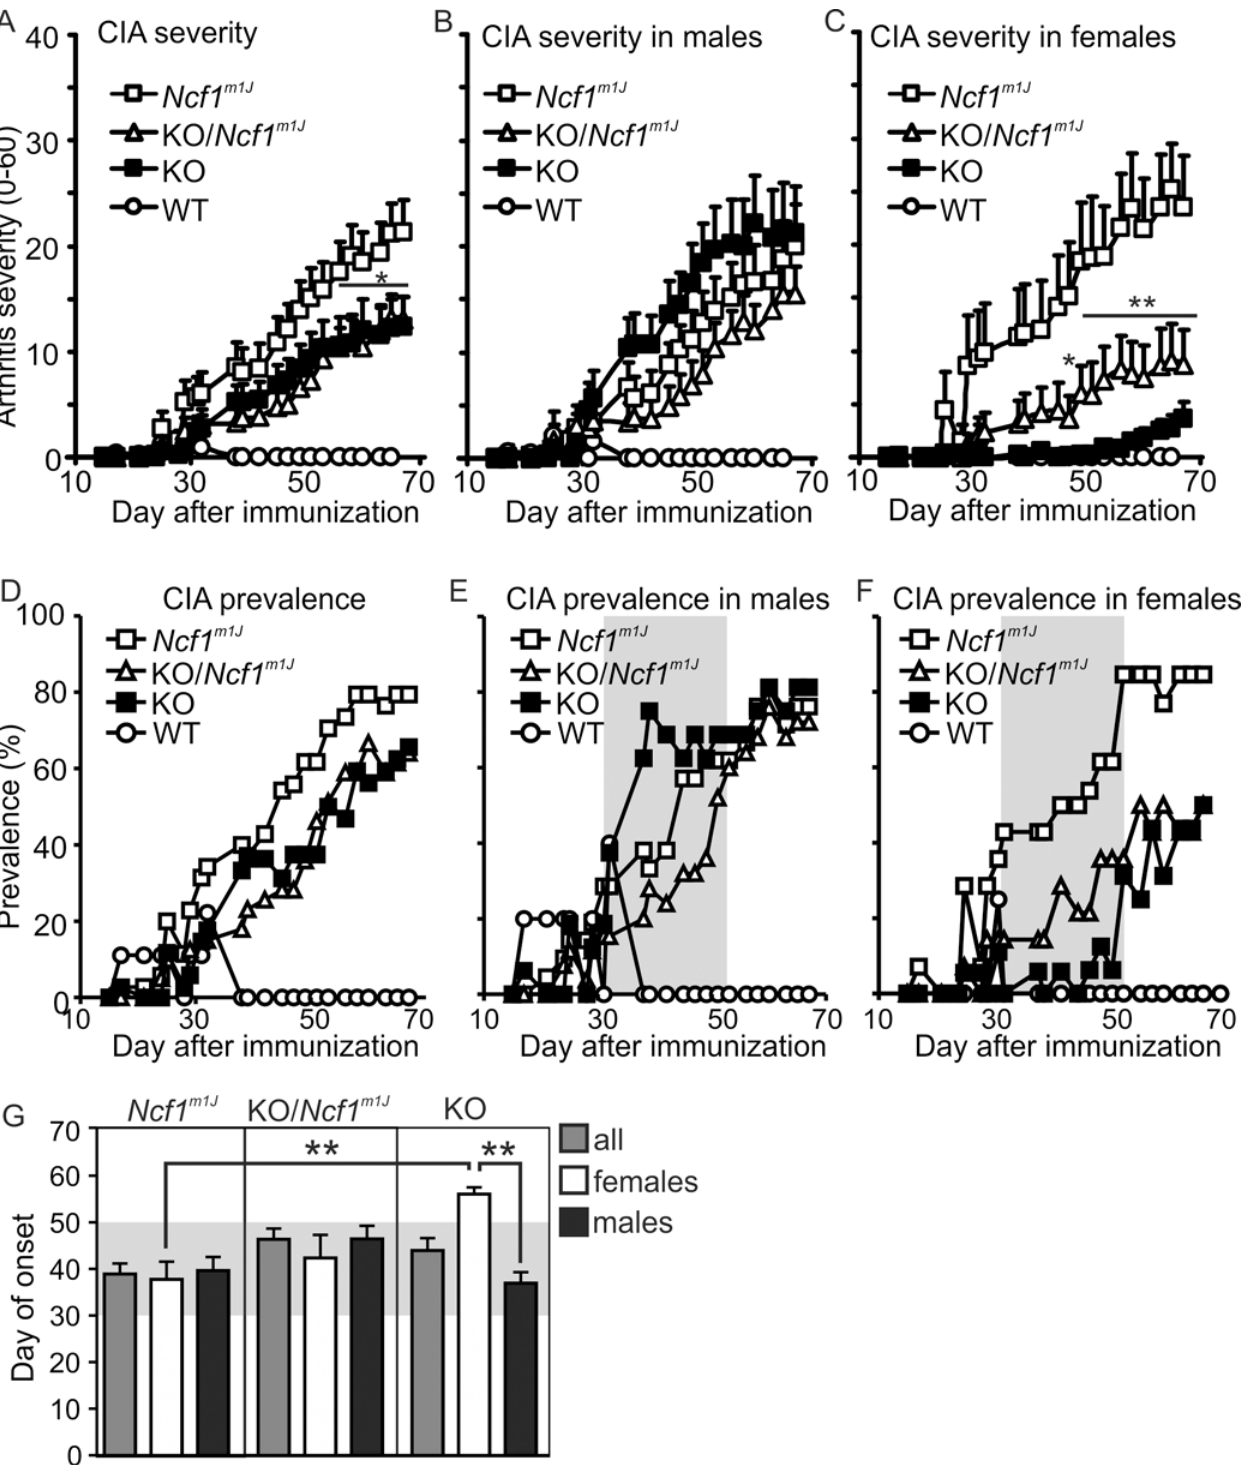
Fig 2. Comparison of collagen induced arthritis (CIA) in Ncf1 knockout and Ncf1 m1J mice. Arthritis severity was evaluated by macroscopic scoring of paw inflammation (see methods for details) and presented by genotype (A) or shown separately for males (B) and females (C). Prevalence of paw inflammation is presented by genotype (D) or shown separately for males (E) and females (F). The data is pooled from two identically performed experiments with similar results. The wild type littermate controls were included only in the first experiment. Statistical significances between the knockout (KO)